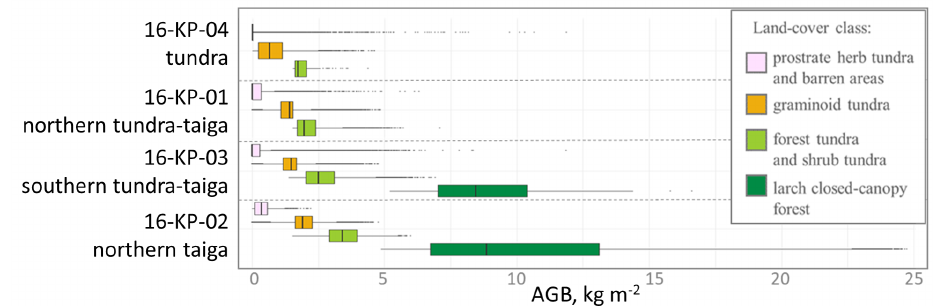
Figure 10. Average above-ground biomass (AGB) in recent years (2016/2017) within land-cover classes that have not changed between 2000 and 2017 for four investigated locations, covering a vegetation gradient from tundra (16-KP-04) via tundra–taiga (16-KP-01, 16-KP-03) to northern taiga (16-KP-02). Table 3. Above-ground biomass (AGB) change associated with land-cover class change in four focus areas from 2000/2001/2002 to 2016/2017. Land-cover class change Tundra 16-KP-04 Northern tundra– Southern tundra– Northern taiga